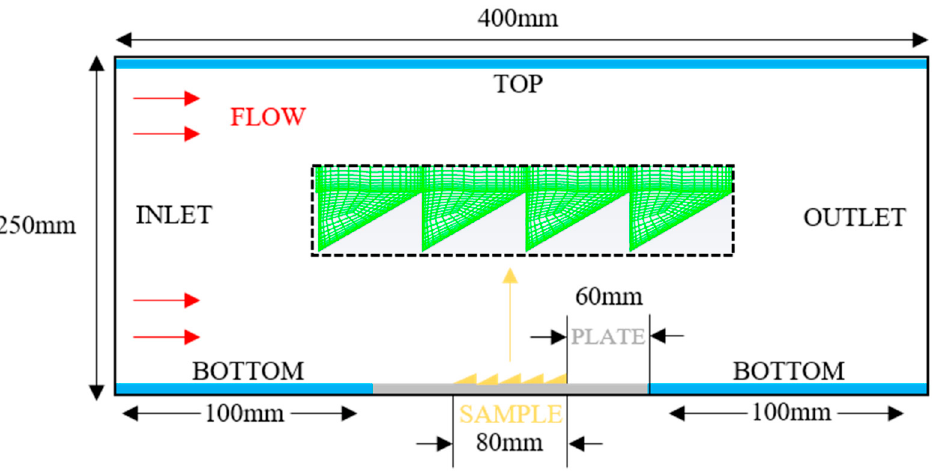
Figure 1. Numerical simulation domain of microstructure surface.